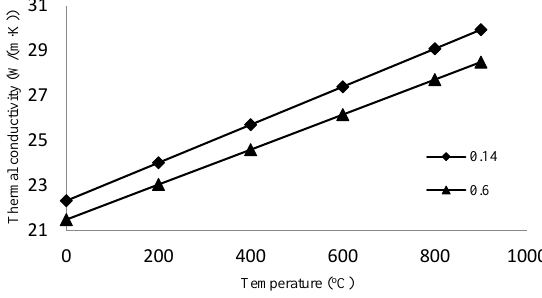
Figure 3. Thermal conductivity of the AISI 1045 steel with respect to the temperature for atom contents (here is the carbon content) of 0.14 and 0.6 percent.